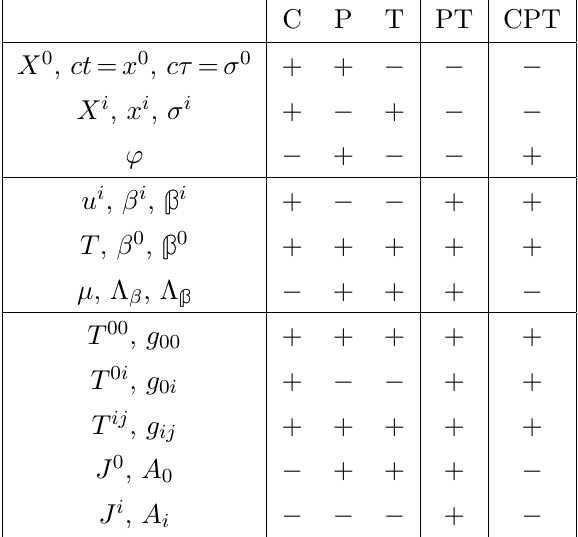
Table 2 . Action of parity (P), time-reversal (T), and charge conjugation (C) of various quantities in classical relativistic hydrodynamics and e(cid:11)ective (cid:12)eld theory. Schwinger-Keldysh double copies of various quantities in the e(cid:11)ective theory, \1 = 2" or \ r=a ", behave the same as their unlabelled